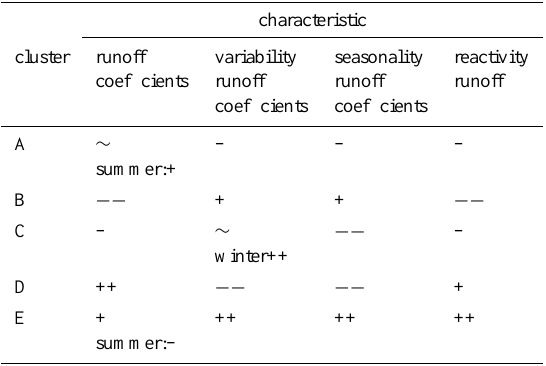
Table 2. Characteristics of cluster A to E by catchment response